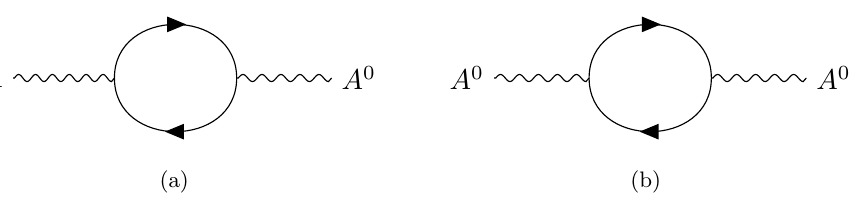
Figure 3 . One-loop diagrams contributing to the (cid:12)eld independent CS terms involving the KK photon A 0 in three